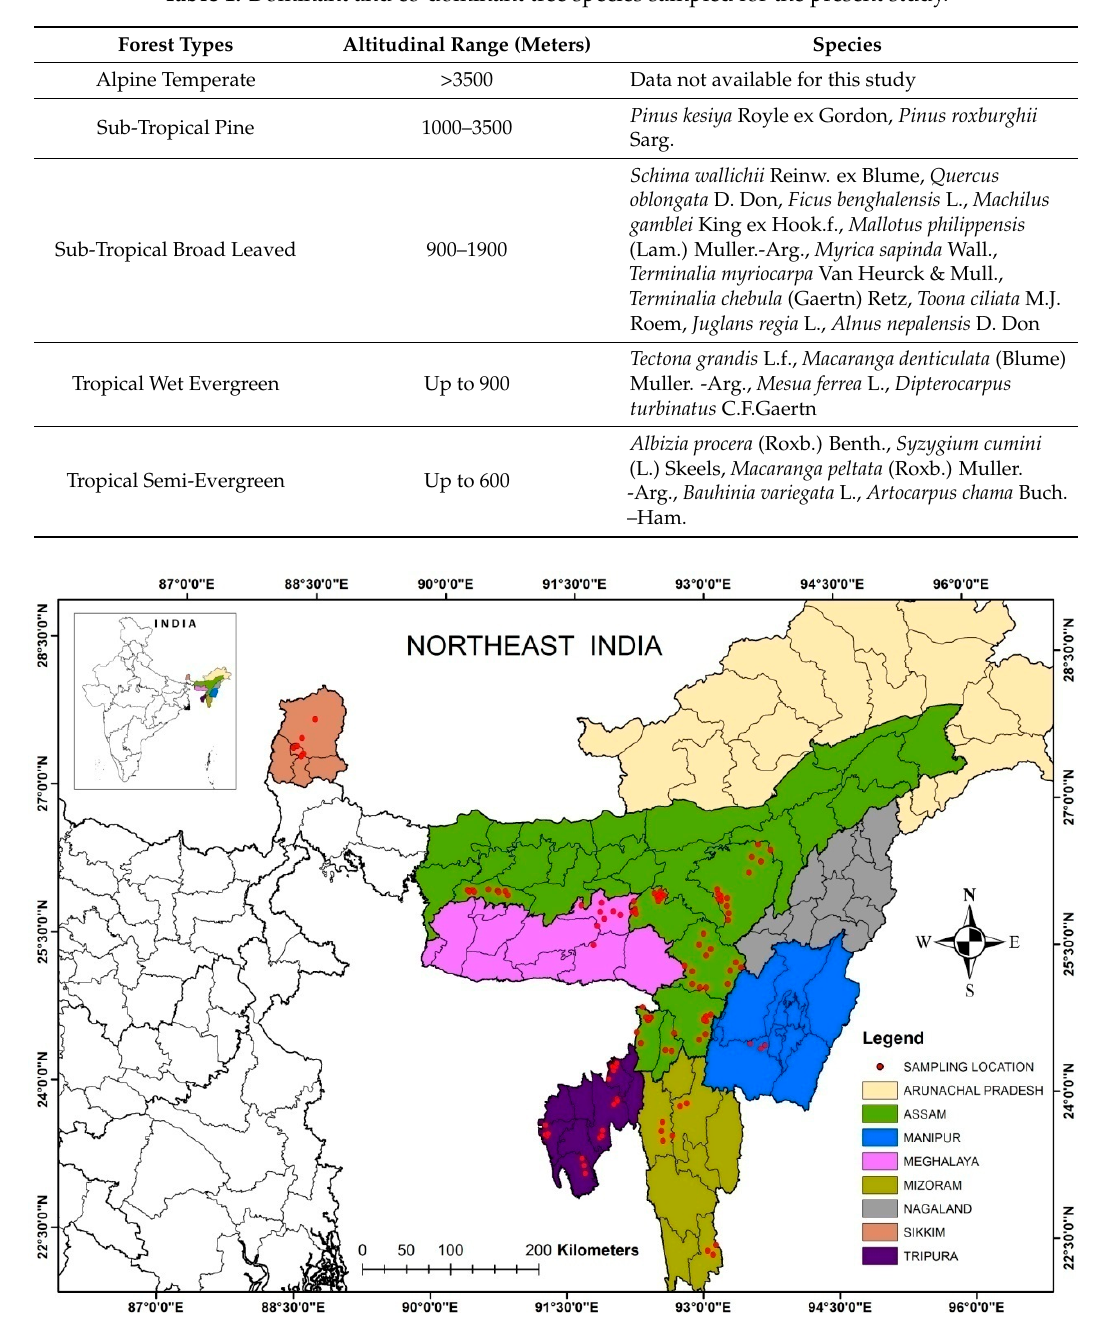
Figure 1. Geographical location of sampling points.